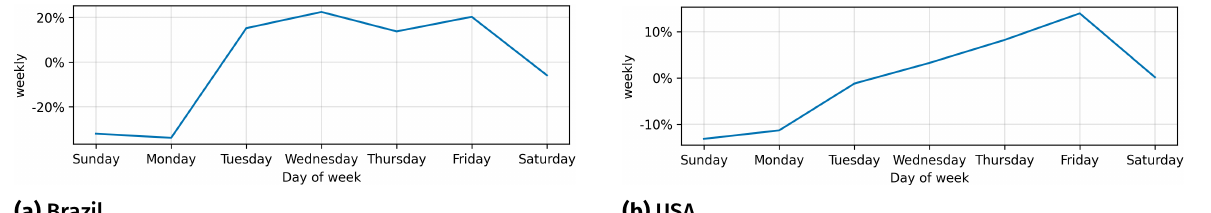
Figure 11. The components plot of weekly seasonality for both